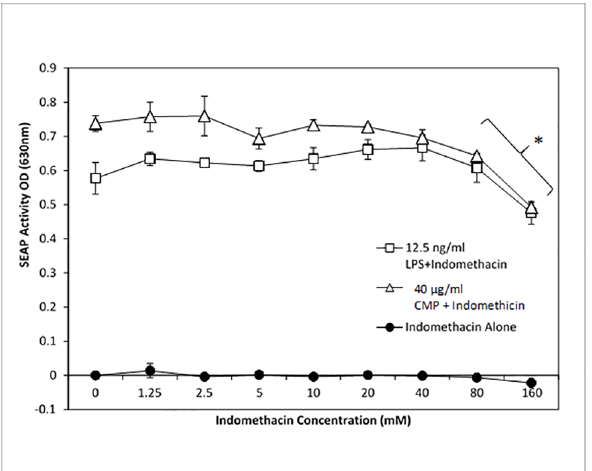
Fig 8. Indomethacin inhibits TLR4 activation only at high concentrations. HEK-TLR4 cells were pre- treated with a range of indomethacin concentrations (0–160 μ M) for 1 h. After pre-treatment, cells were subjectedto stimulationwith media (filled circles), 12.5 ng/mL LPS (open squares)or 40 μ g/mL CMP (open triangles). Ligandconcentrations were selected after determiningthe lowest concentration requiredto achievenear-maximal SEAP activity. SEAP activity was measuredafter overnightincubationto evaluate cellularactivation. The asterisk representsthe significance(p (cid:20) 0.05) whereinthe variancein mean SEAP activity of media plus indomethacin is comparedwith CMP or LPS treatments in the presence of 160 μ M indomethacin.